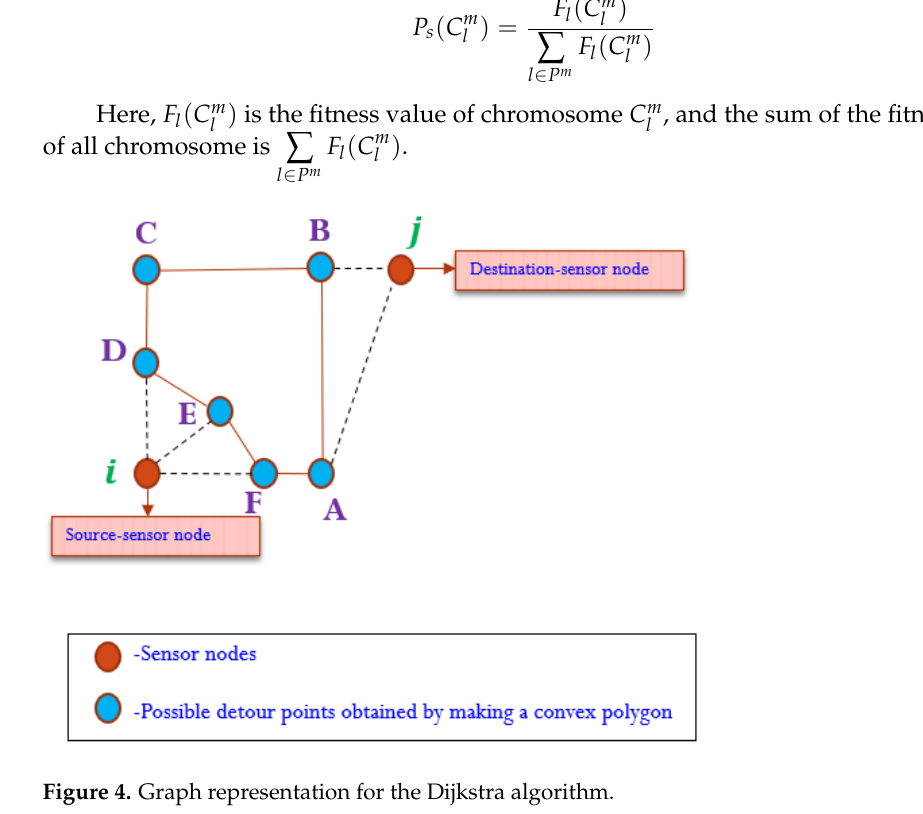
Figure 4. Graph representation for the Dijkstra